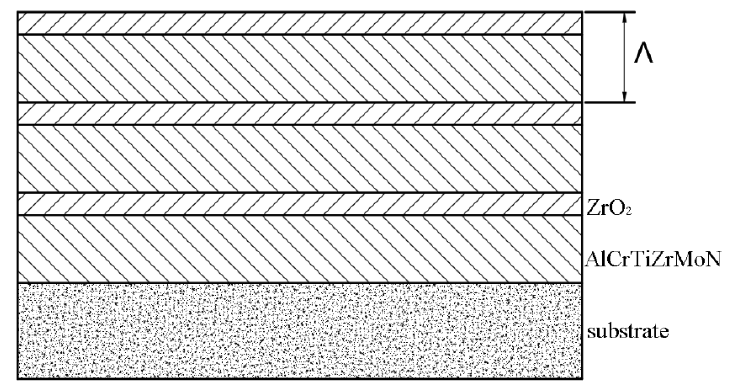
Figure 1. Schematic illustration of the (AlCrTiZrMo)N/ZrO 2 nano-multilayered film. The microstructures of (AlCrTiZrMo)N/ZrO 2 nano-multilayered films and monolithic (AlCrTiZrMo)N films were characterized by the D8 Advance X-ray diffractometer (XRD, Bruker, Mannheim, Germany) using CuK α radiation ( λ = 0.15406 nm), the Quanta FEG450 field-emission environmental electron microscope (SEM, FEI, Hillsboro, OR, USA), and Tecnai G220 high-resolution field-emission transmission electron microscope (HRTEM, FEI, Hillsboro, OR, USA). The XRD patterns were measured using the Bragg–Brentano ( θ /2 θ ) scan mode with parameters of 30 kV and 20 mA. The diffraction angle of the XRD pattern ranges from 25 ◦ to 90 ◦ . The elemental distributions were analyzed by an electron probe microanalyzer (EPMA, JXA-8530F PLUS, Tokyo, Japan). The hardness and elastic modulus of the films were measured by a G200 nano-indentation system (Agilent, Santa Clara, CA, USA). A Berkovich diamond indenter was used with a loading rate of 0.05/s, a load of 5 mN, and a press-in depth of 100 nm, which was less than 1/10 of the film thickness so that the influence of the substrate on the mechanical properties of the film could be eliminated. At least 16 points were selected for the hardness measurement of each film, and the data with a coefficient of variation of less than 10% were selected to calculate annealed in air for 30 min at 700 ◦ C, 800 ◦ C, 900 ◦ C, 1000 ◦ C, and 1100 ◦ C. The sample was 100 ◦ C/min. The structural changes and mechanical properties of the annealed samples were measured by the XRD and nanoindentation techniques. Table 1 shows the deposition parameters and the element contents of the (AlCrTiZrMo)N/ZrO 2 nano-multilayered